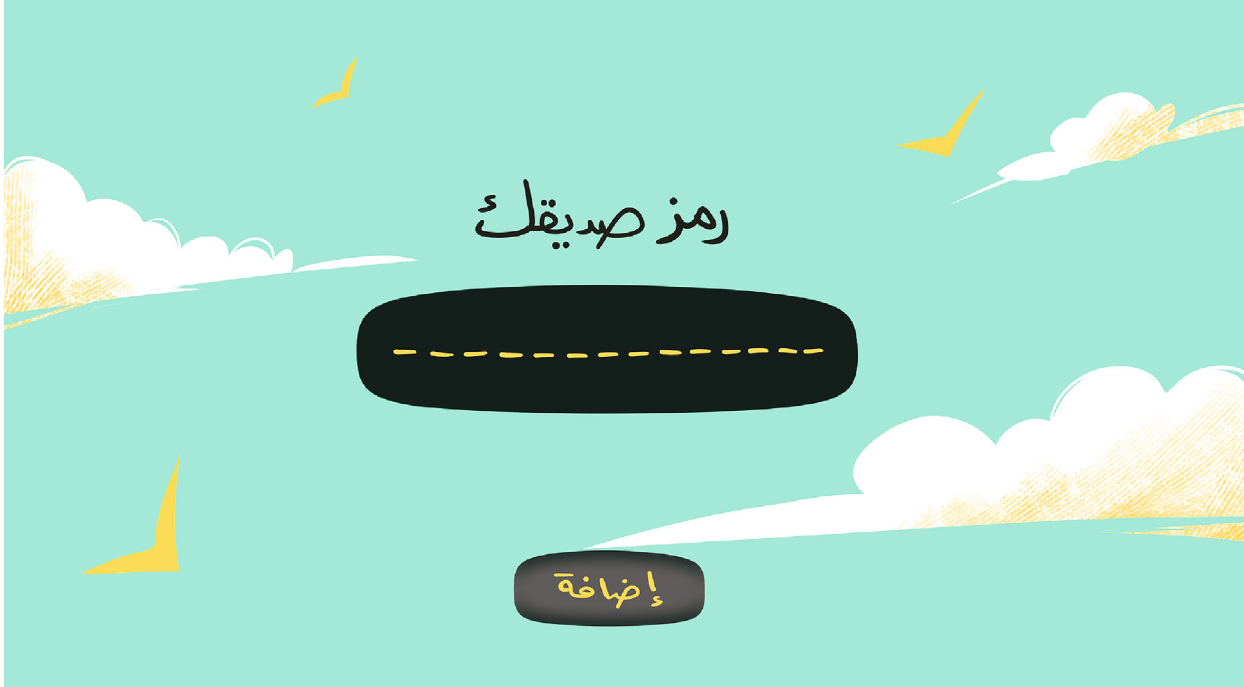
Figure 5: Adding friends screen.